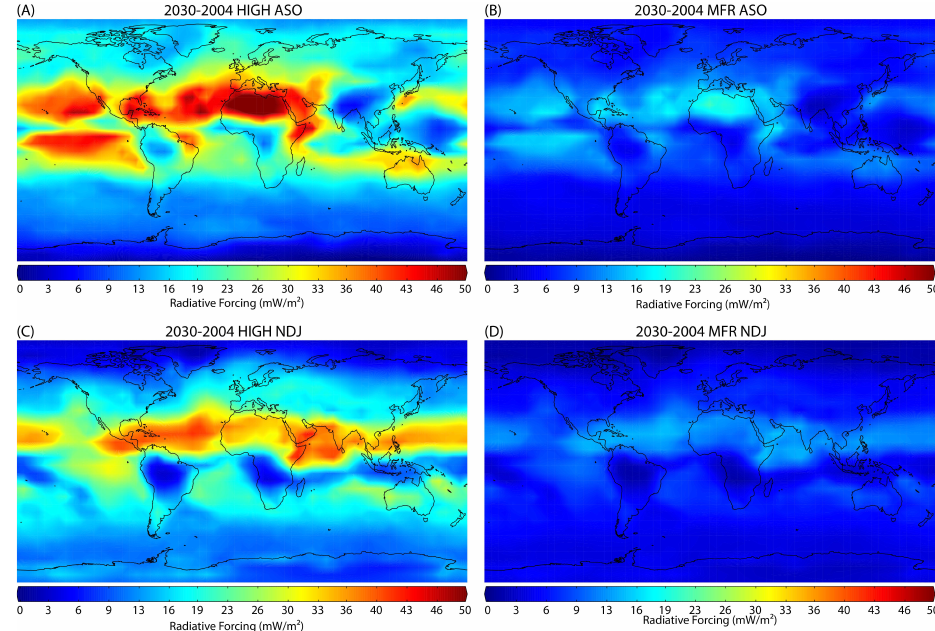
Fig. 8. Ozone RF 2004–2030 (mWm − 2 ) . (A) HIGH scenario, ASO season. (B) MFR scenario, ASO season. (C) HIGH scenario, NDJ season. (D) MFR scenario, NDJ season.